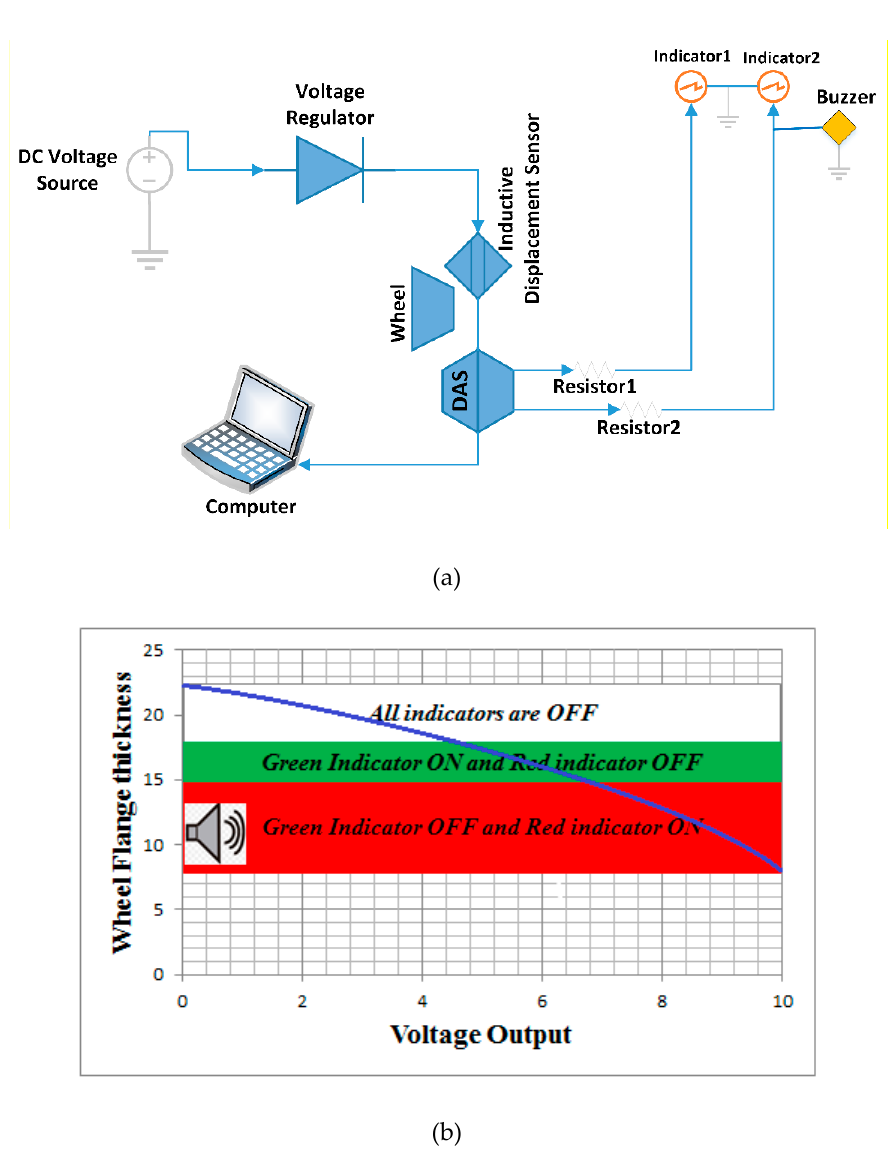
Figure 1. ( a ) Schematic diagram of intelligent system used to measure the wheel flange thickness. ( b ) Wheel flange thickness status in train’s cab .